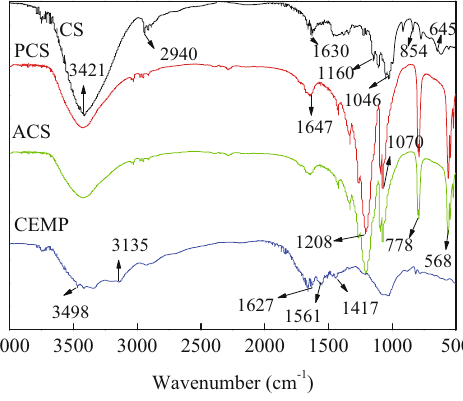
Figure 1: FTIR spectra of CS, PCS, ACS